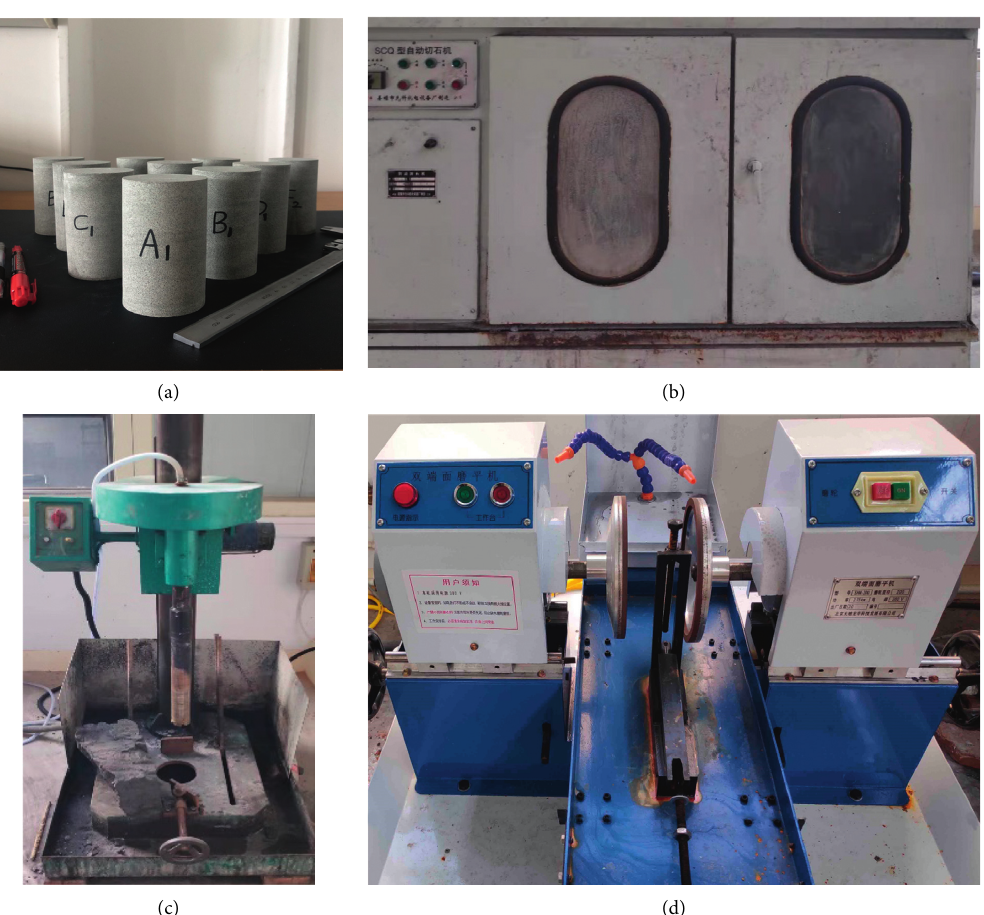
Figure 2: Test samples and instruments. (a) Part of sandstone samples, (b) SCQ type automatic stone cutter, (c) core drilling machine, and (d) automatic grinding machine.